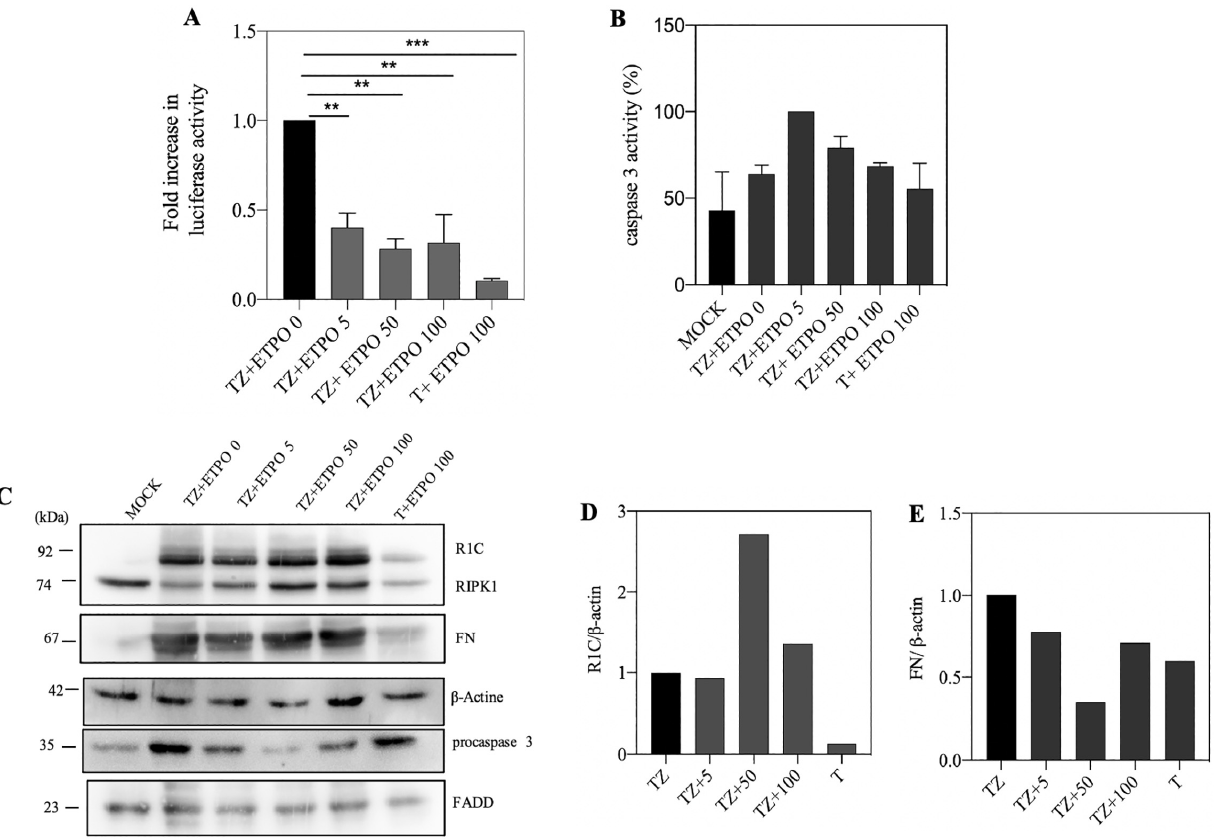
Figure 4. Etoposide effect on the binding of R1C and FN. ( A ) SH-SY5Y cells cotransfected with R1C and FN constructs by PEI. 24 h after transfection, cells treated with TZ or T and 2 h later, etoposide (5, 50 and 100 µM) were added. Split luciferase activity shows that interaction between R1C and FN decreased in presence of ETPO. ** p ≤ 0.01; *** p ≤ 0.001. ( B ) and Ac-DEVD-AMC activity increased with etoposide treatment. ( C ) Western blotting of recombinant and endogenous proteins ( D , E ) shows typical normalization of R1C and FN expression in western blot compared to β -actin.